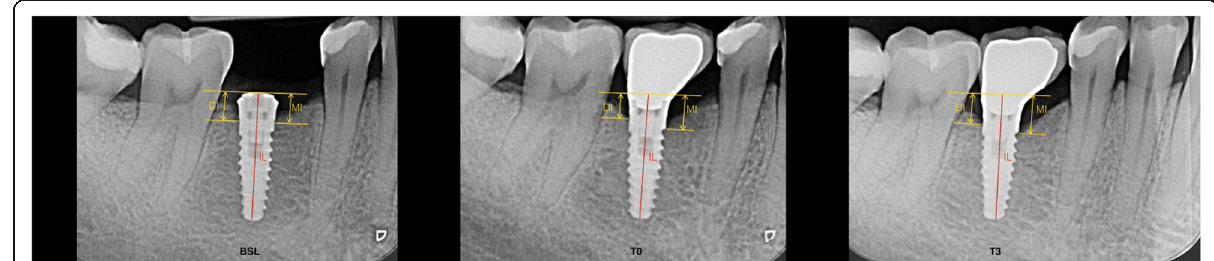
Fig. 2 Example of the location of a submerged implant, bone, and adjacent